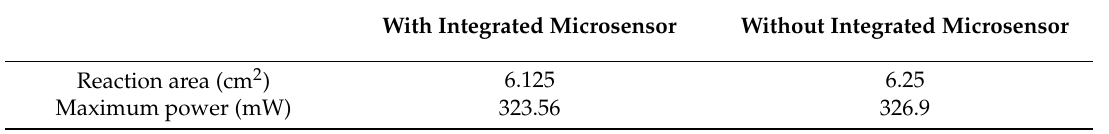
Figure 10. Local temperature distributions of wired and wireless sensors.